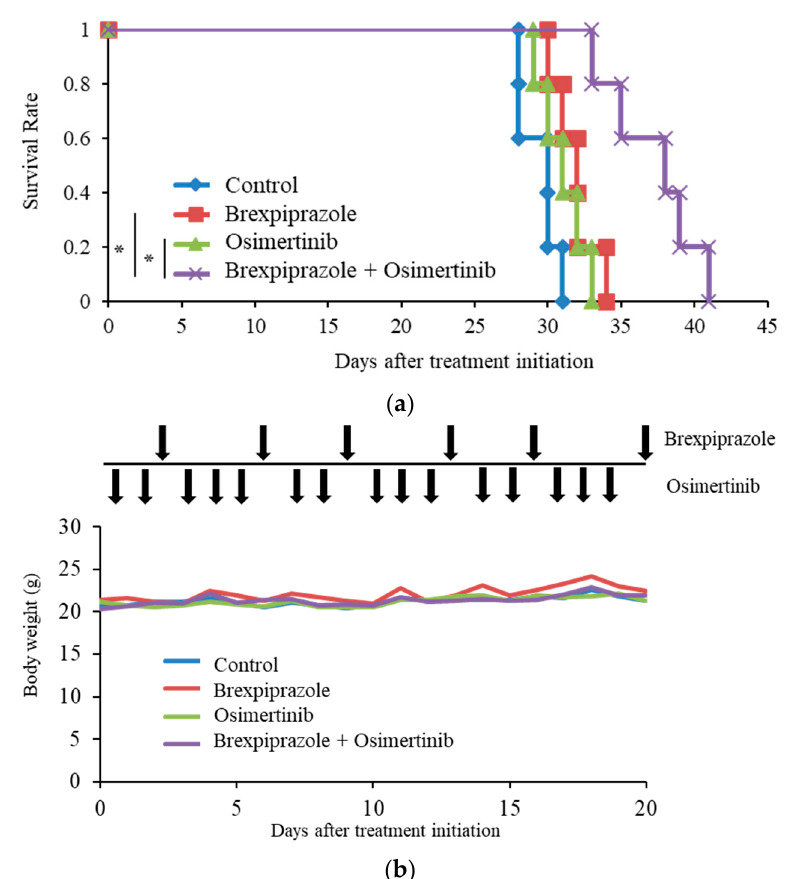
Figure 4. Systemic combination administration of brexpiprazole and osimertinib has anticancer stem effects in vivo. After patient-derived GSCs (GS-Y03, 1 × 10 4 cells) were intracranially injected to the left-brain hemisphere of nude mice, the indicated drugs (3 mg/kg of brexpiprazole twice a week and 5 mg/kg of osimertinib 5 times a week) were orally administered after 2 days. ( a ) Survival was evaluated by a Kaplan–Meier analysis. ( b ) The body weights of the mice (means with SD) were presented. Arrows indicate the treatment schedule. * p < 0.05.